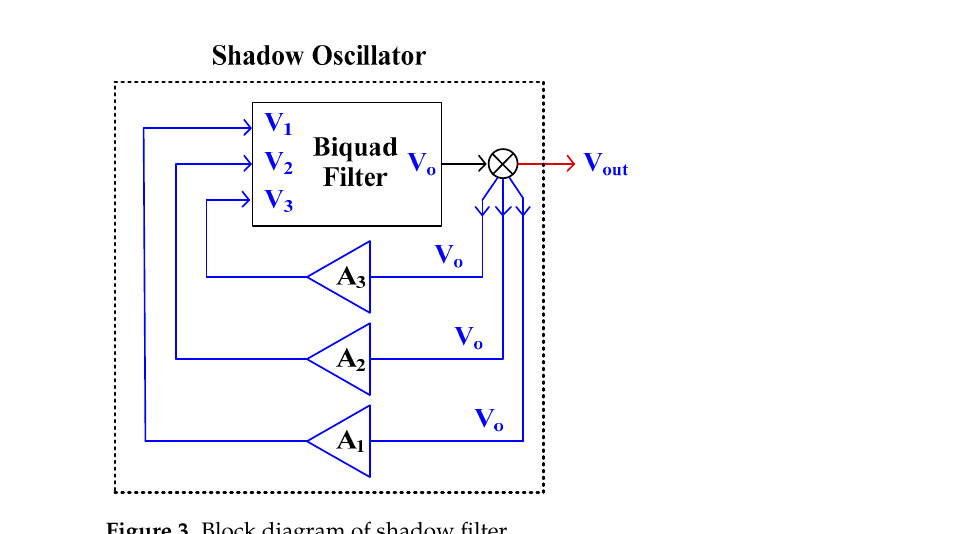
Figure 3. Block diagram of shadow filter.